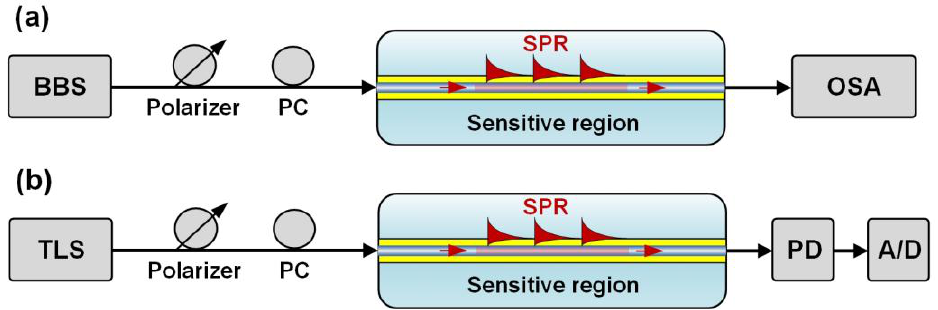
Figure 11. Scheme of the classic implementations of ( a ) spectral, and ( b ) intensity interrogation, of the sensors in transmission.